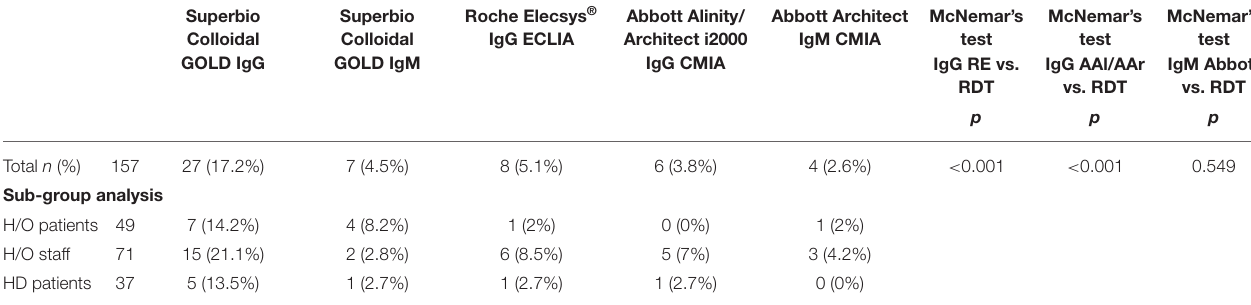
TABLE 2 | Positive results in each cohort and results of McNemar’s test between RDT and laboratory assays. Superbio